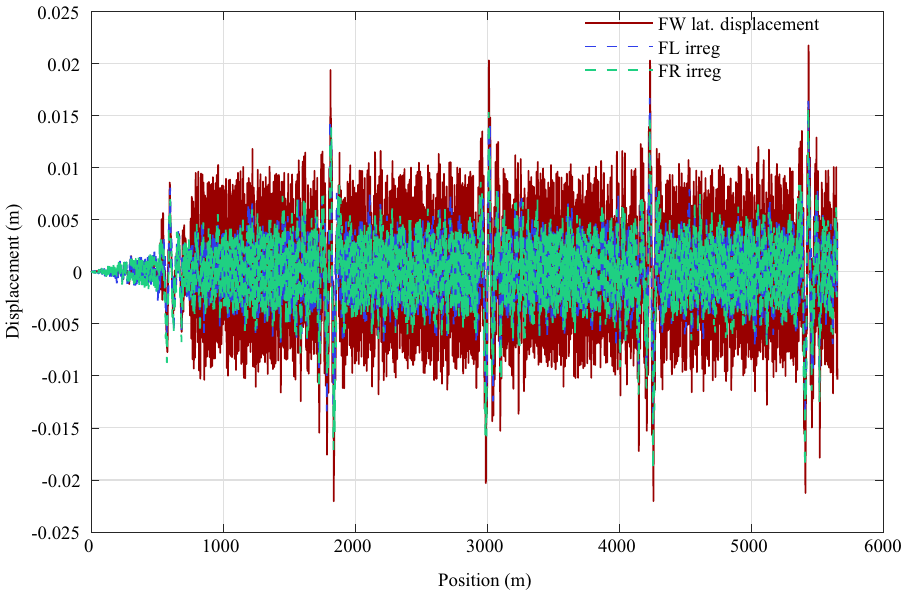
Fig. 11 Simulation with centerline variations with 4 mm amplitude and 10 m wavelength. The red line shows the lateral displacement of the front wheelset, and the blue and green dashed lines show the lateral displacement of the left and right rail, respectively, at the position of the front wheelset